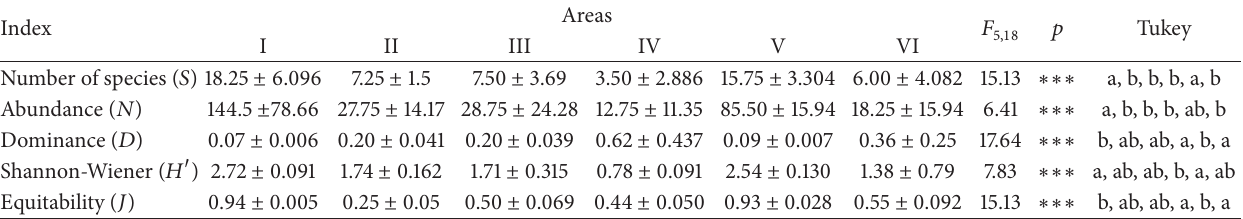
Table 3: Mean ± standard deviation of diversity parameters of fish species and abundance recorded in the intertidal zone of the Amazon River at Macap´a, Amap´a